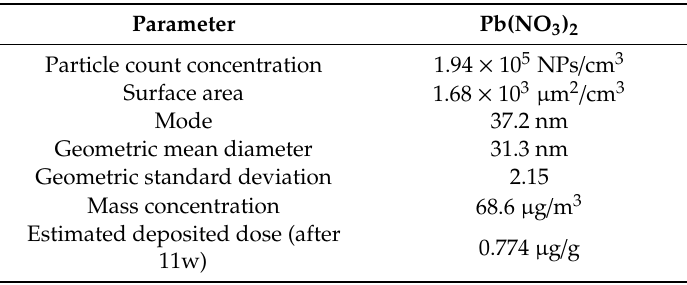
Table 1. The characterization of generated Pb(NO 3 ) 2